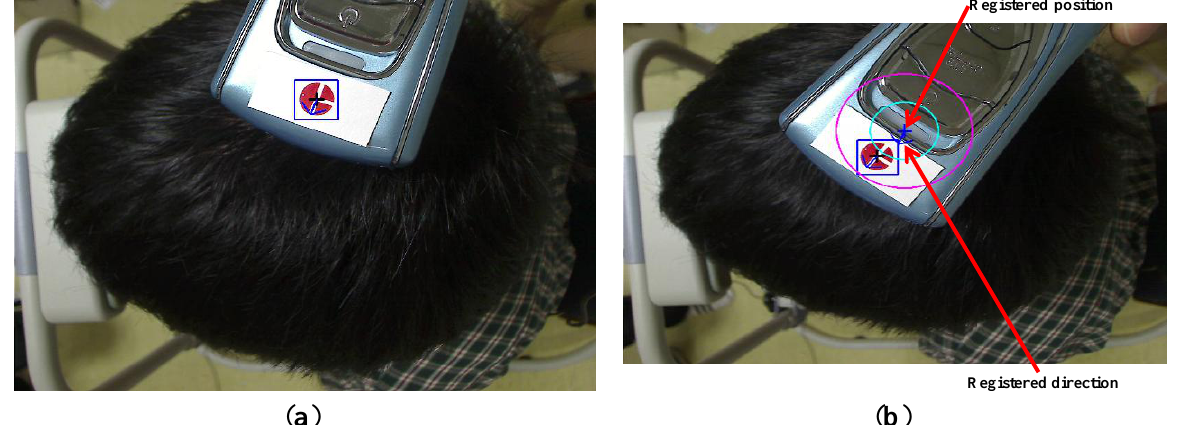
Figure 10. Detected center and direction of color marker and facial feature positions. ( a ) Detected center and direction of marker (registration mode in Figure 3); ( b ) Moving the diagnostic device to the registered position and in the direction of the marker (treatment mode in Figure 3); ( c ) Manually detected facial feature